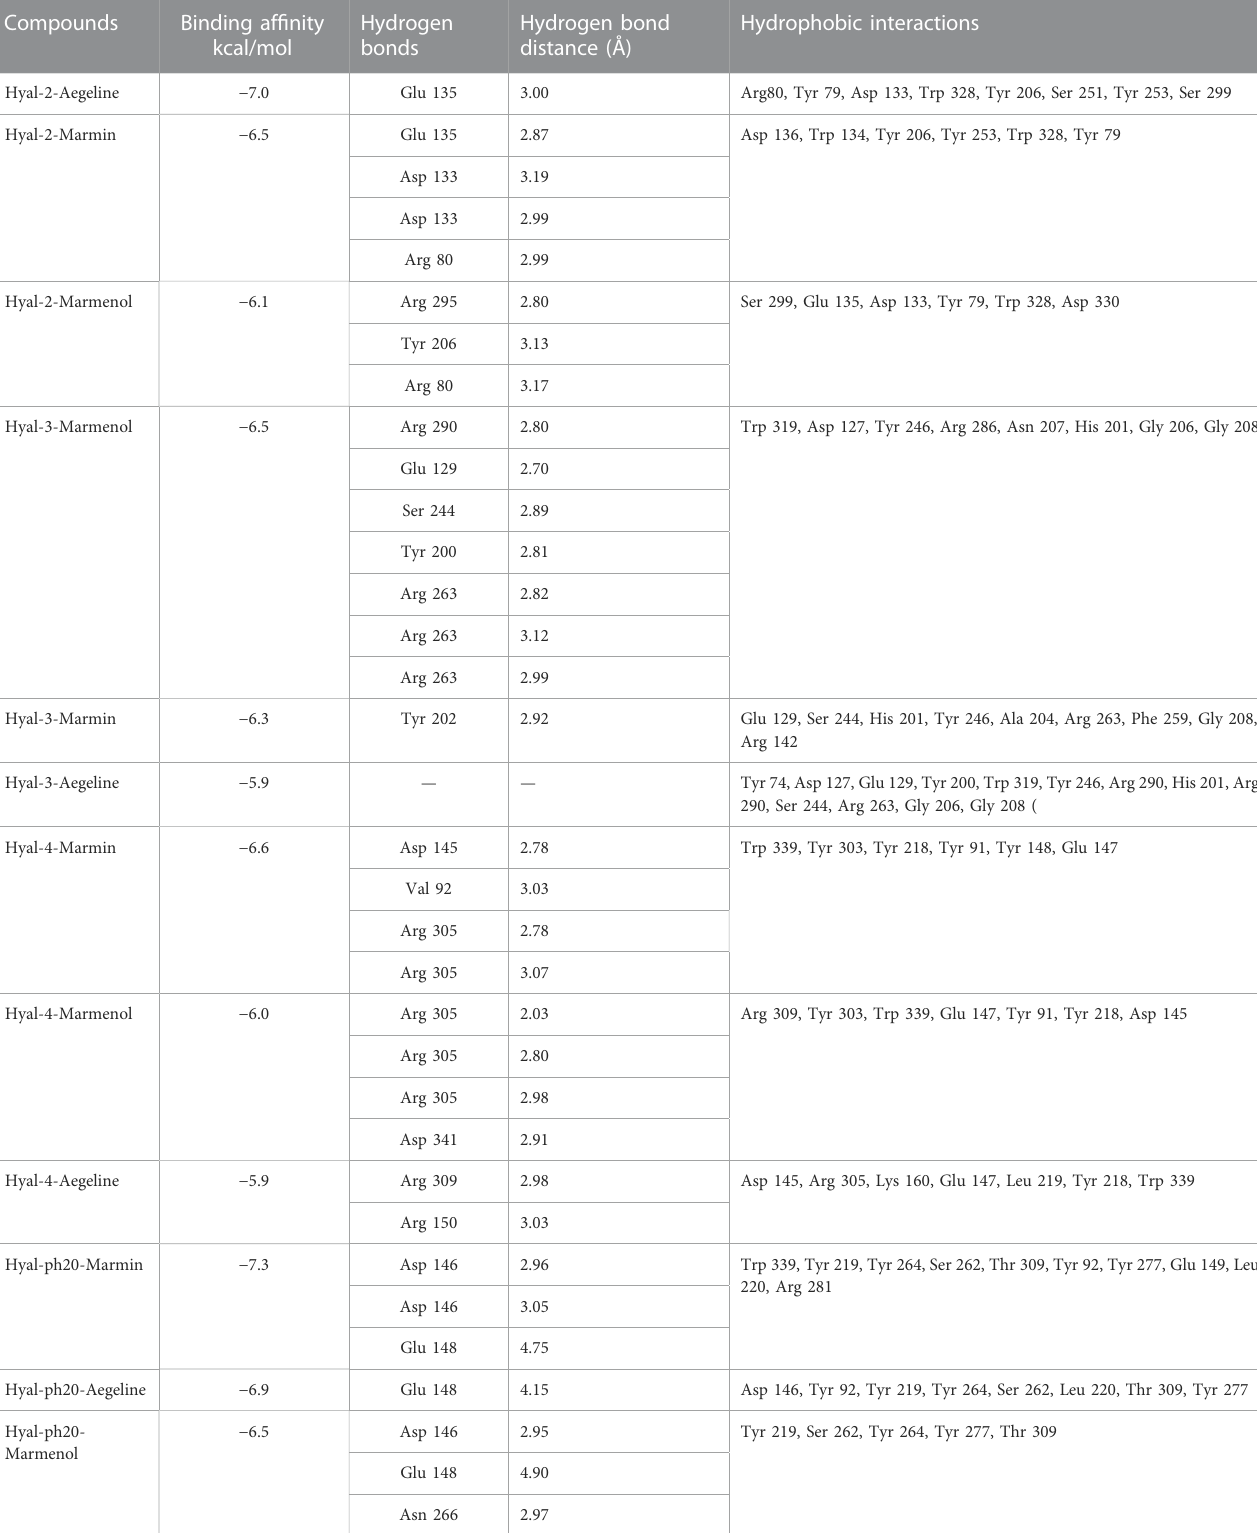
TABLE 5 Hydrogen and Hydrophobic interaction data analyzed using LigPlot from the molecular docking results.